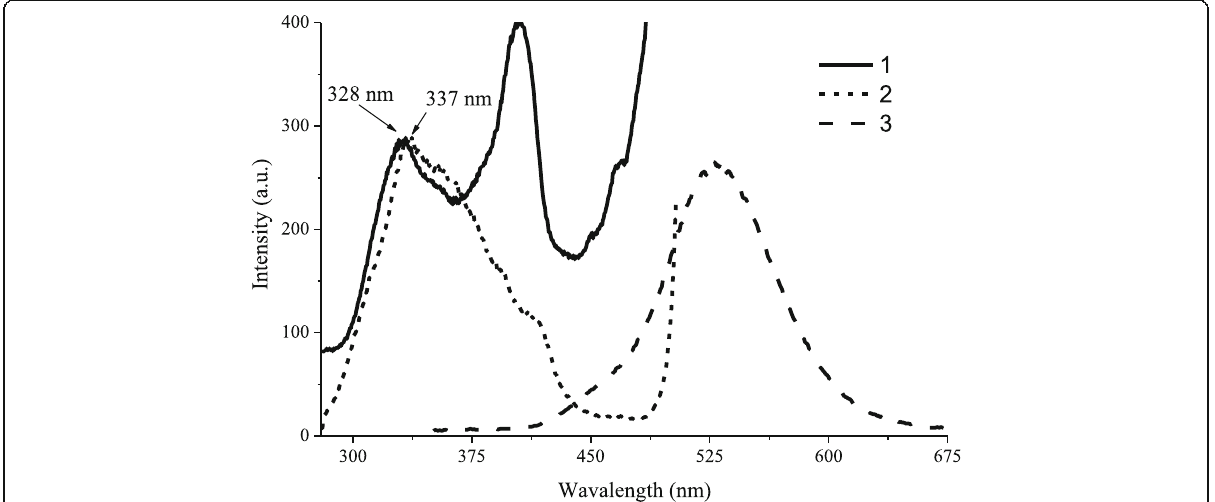
Fig. 2 PLE spectra of SHS-synthesized ZnS:Cu, normalized on the intensity fundamental absorption band. 1 – initial ZnS:Cu – SHS, 2 – ZnS:Cu – SHS after washing in distilled water. 3 – PL spectrum of initial ZnS:Cu – SHS